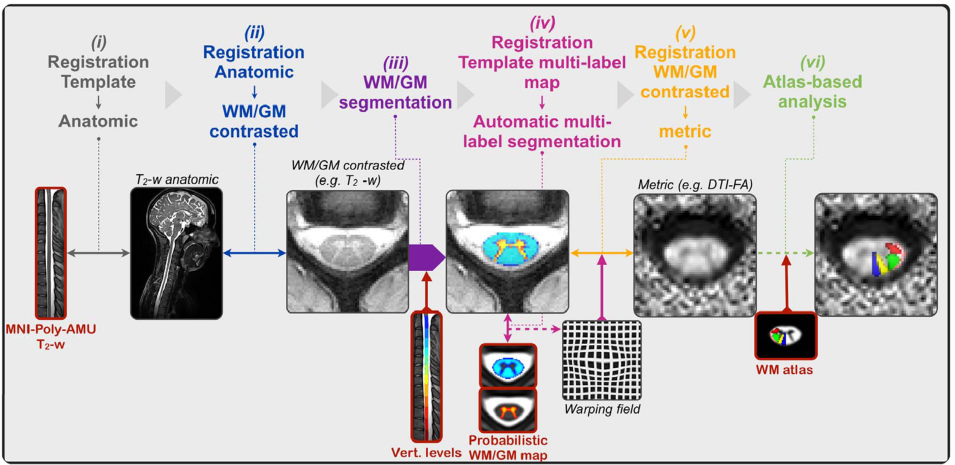
Figure 3. Registration framework for the extraction of metrics using the template. Template-based elements are shown in red. The figure has been adapted from Dupont et al. 2017 [32].